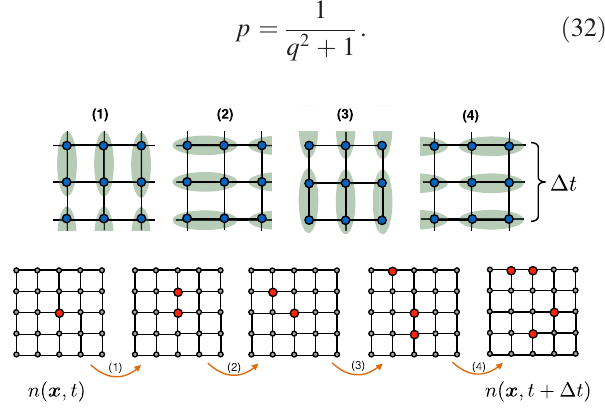
FIG. 4. Top row: 2 þ 1 D Haar-random quantum circuit. We consider unitary dynamics in which two-site Haar-random unitaries are applied on the bonds of a two-dimensional square lattice, in the columnar dimer configurations shown in (1) – (4). Bottom row: Allowed updates in the corresponding stochastic